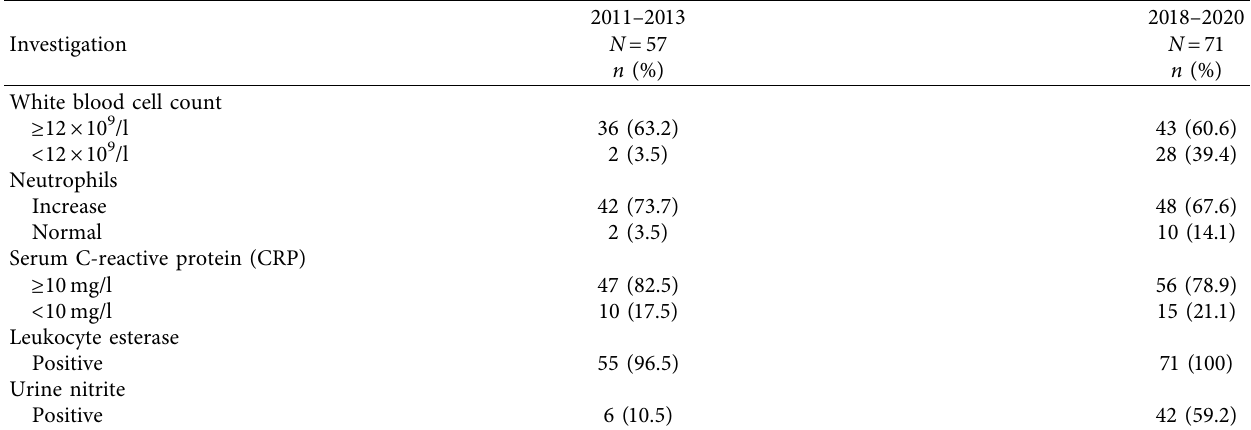
Table 2: Investigation results of included children ( N � 128).